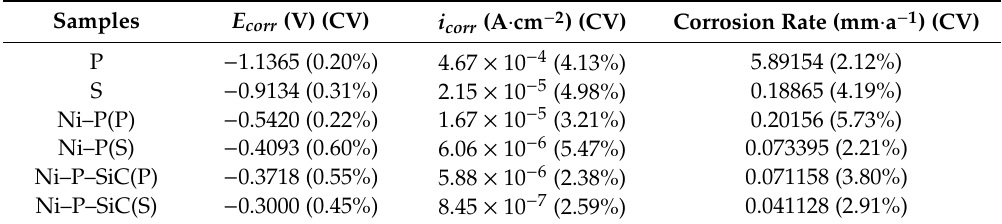
Table 4. Polarization curve parameters of coatings prepared by scanning electrodeposition on 45 steel substrates with di ff erent pretreatment